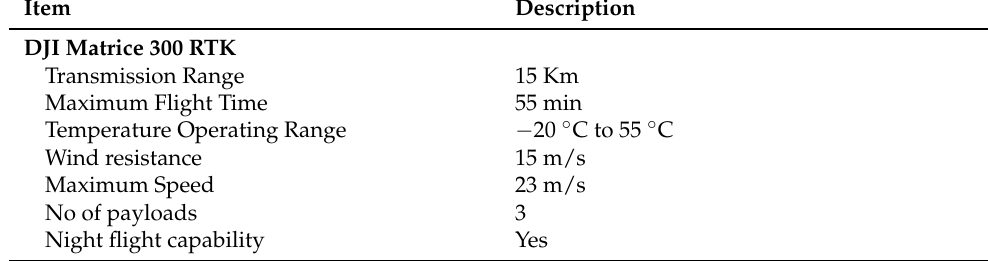
Table 1. Specifications of the UAV, payload, hygrometer, and infrared